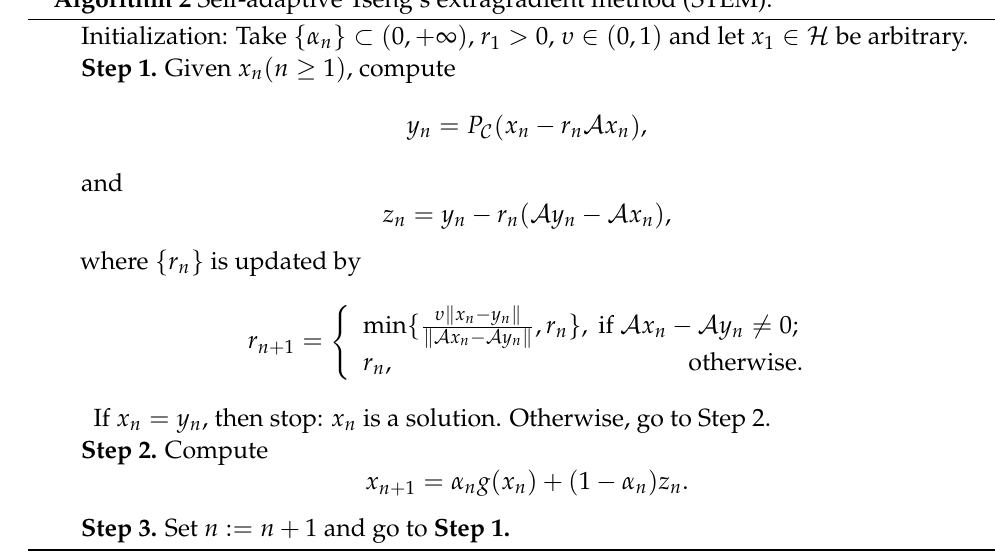
Algorithm 2 Self-adaptive Tseng’s extragradient method (STEM).